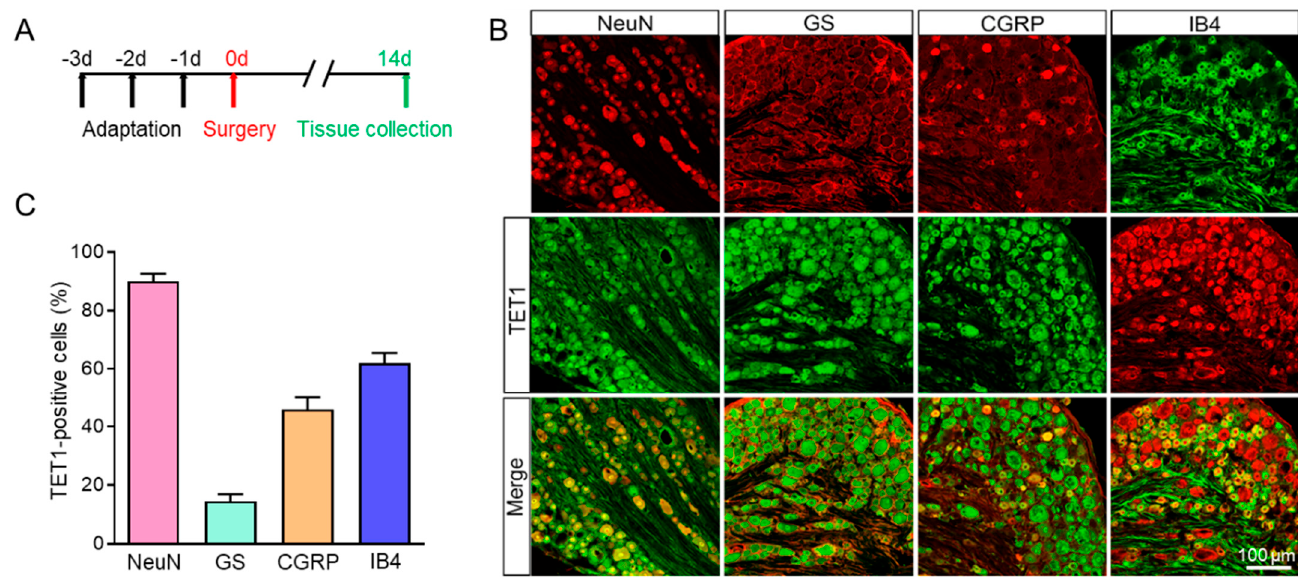
Figure 3. Immunofluorescence assay of TET1 in the L4–6 DRG of BCP rats. ( A ) The schematic diagram. ( B ) TET1-positive DRG cells (middle row) were mainly co-labeled as neurons (NeuN) but not with satellite glial cells (GS). TET1 was co-expressed in CGRP-positive and IB4-positive DRG neurons. ( C ) The proportion of TET1-positive cells in different cell types, n = 4.